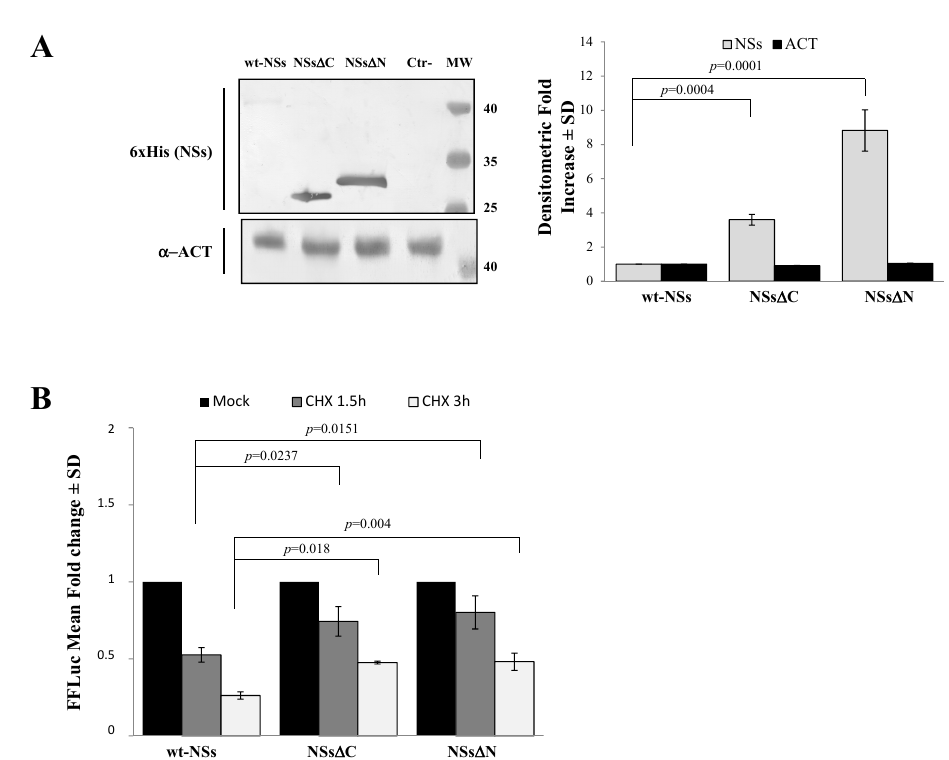
Figure 2. Domains a ff ecting TOSV NSs stability. ( A ) The involvement of TOSV NSs C- and N-terminal regions on protein stability was demonstrated by generating deleted NSs proteins (NSs ∆ C and NSs ∆ N). The behavior of the deleted NSs variants was tested by immunoblotting on the whole-cell lysates (50 µ g) of Lenti-X 293T-transfected cells. Specific proteins were detected by using anti-6 × His (NSs) monoclonal antibody (left figure). Loading control was represented by actin ( α -ACT) detection (left figure). Quantitative assessment of deleted NSs variants was determined by densitometric analysis (right figure). ( B ) Lenti-X 293T cells were transfected with FFLuc NSs ∆ N and NSs ∆ C fusion constructs and Renilla Luciferase as an internal control. Transfected cells were mock-treated or treated with cycloheximide (CHX) and collected at 1.5 and 3 h. Fold induction was obtained by luciferase activity normalization with respect to Renilla luciferase values and comparison to the relative mock-treated sample. Results were expressed as mean fold change values collected in at least three independent experiments ± standard